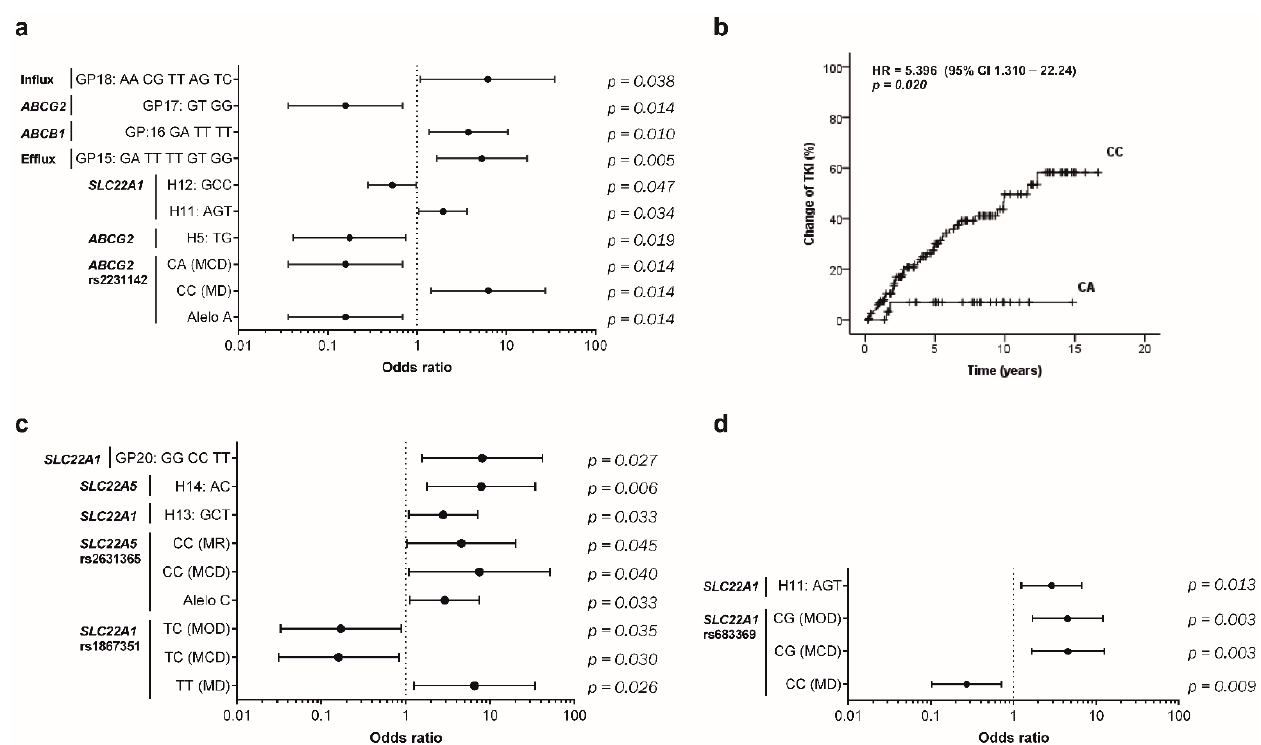
Figure 2. Prognostic impact of SNVs in influx and efflux transporters genes in CML patients. In ( a ) are the alleles, genotypes, haplotypes (H), and genotypic profiles (GP) significantly associated with TKI response in CML patients; ( b ) depicts the time to TKI change in CML patients according to ABCG2 (rs2231142) genotypes. This analysis was performed by the Kaplan Meier–method, differences in survival were tested with the log-rank test, and hazard ratios (HR) with 95% confidence interval (CI) were calculated using the Cox proportional hazard model. In ( c ) are the alleles, genotypes, haplotypes, and GPs significantly associated with the number of TKIs needed by CML-resistant patients. In ( d ) are the alleles, genotype, haplotypes and GPs significantly associated with BCR-ABL1 mutations in CML patients. The respective p value is shown for each analysis. Haplotypes groups: ABCG2 : rs2231142/rs2231137; SLC22A1 : rs628031/rs683369/rs1867351; SLC22A5 : rs274558/rs2631365.